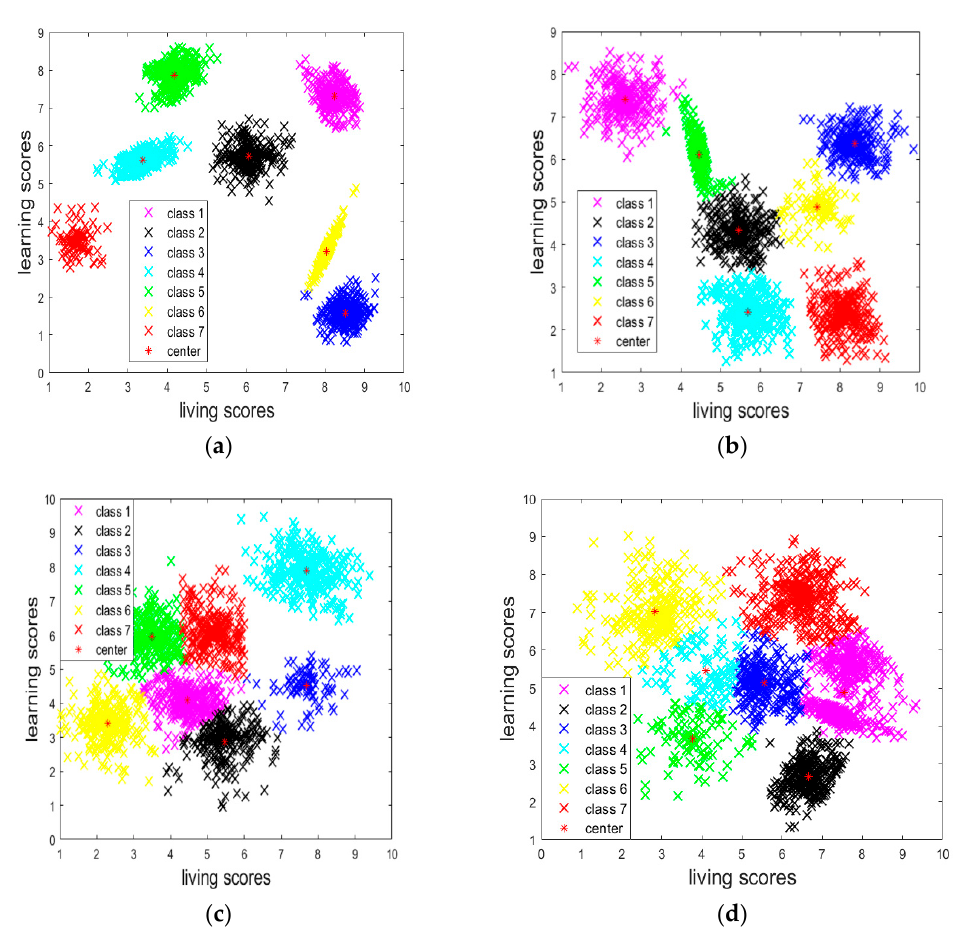
Figure 14. The results graph of the K-Means cluster algorithm: ( a ) S1; ( b ) S2; ( c ) S3; and ( d ) S4.